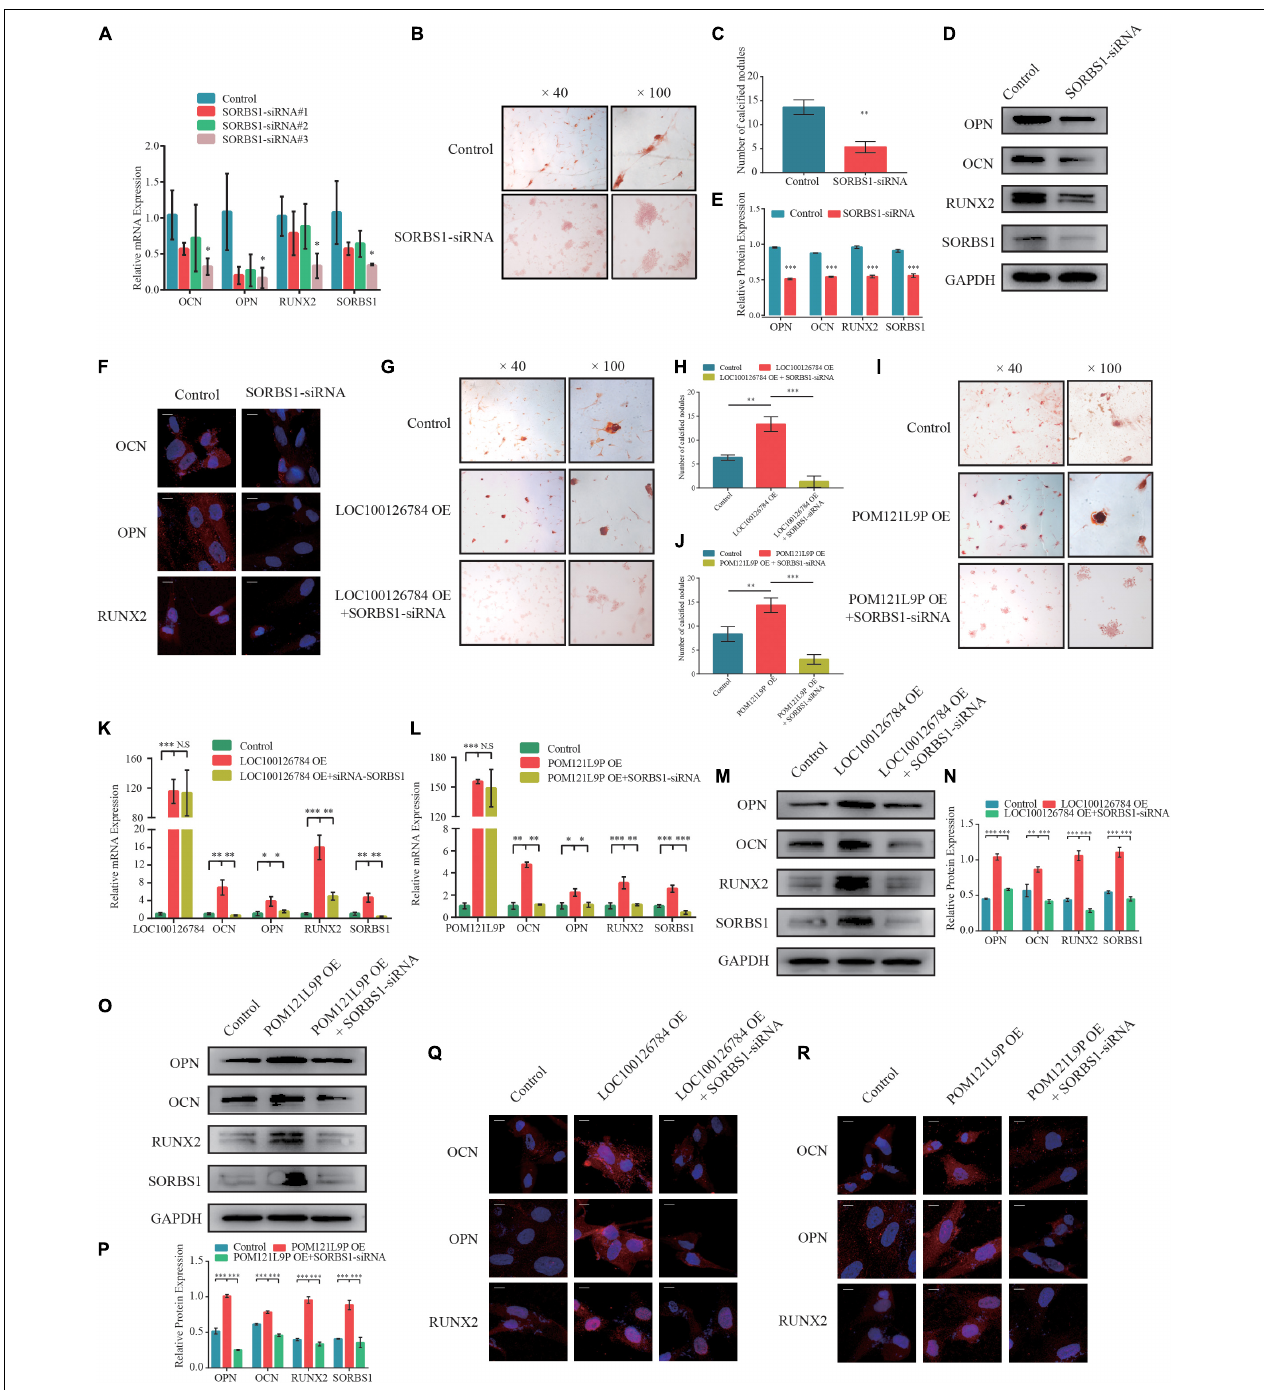
FIGURE 6 | SORBS1 knockdown blocks early osteogenesis in BMSCs and is identified as the downstream of LOC100126784 and POM121L9P. (A) BMSCs were transfected with 100 nM SORBS1 or control siRNA. OCN, OPN, RUNX2, and SORBS1 expression levels as estimated by RT-qPCR. BMSCs were infected with control siRNA or SORBS1 siRNA#3, and then calcium nodes stained with Alizarin Red and observed at × 40 and × 100 magnification on day 7 of osteogenic differentiation (B) . (C) Quantitative analysis of the number of calcium nodules in (B) . Relative OCN, OPN, RUNX2, and SORBS1 protein expression levels as measured by western blotting (D) , quantified protein expression by densitometric analysis (E) , and immunofluorescence (F) . Then, BMSCs were transfected with LOC100126784- or POM121L9P- overexpressing lentiviral plasmids in the presence or absence of SORBS1 siRNA#3. Calcium nodes stained with Alizarin Red were observed and quantitative analysis was performed on day 7 during osteogensis (G–J) . The mRNA levels of OCN, OPN, RUNX2, and SORBS1 were detected by RT-qPCR (K,L) . Western blots with quantitative analysis (M–P) and IF assay (Q,R) were used to assess the protein expressions of OCN, OPN, RUNX2 and SORBS1. Quantitative data are presented as mean ± SD of three independent experiments. ∗ p < 0.05, ∗∗ p < 0.01, ∗∗∗ p < 0.001.